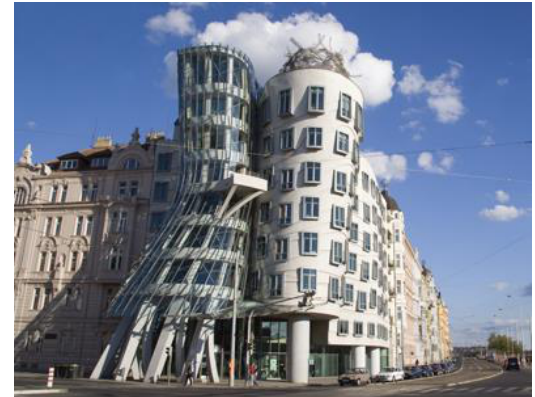
Fig.29 Guggenheim Museum (Bilbao, 1997)